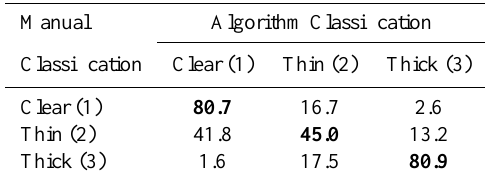
Table 6. Confusion matrix for CDOC of training set based on fixed RBR thresholds. All values are in [%] and add up to 100% across rows. Manual Algorithm Classification